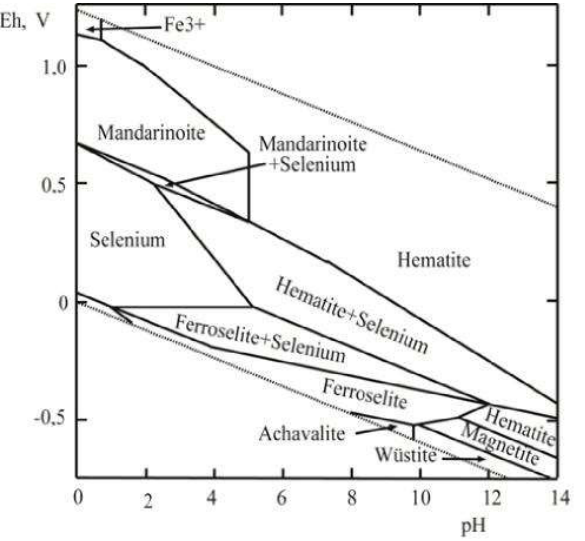
Figure 5. Eh‒pH diagram of Fe-Se-H 2 O system at 25 °C and the activities of the components: a ΣSe = 10 - Figure 5. Eh-pH diagram of Fe-Se-H 2 O system at 25 ◦ C and the activities of the components: a Σ Se = 5 , a ΣFe = 10 -2 . 10 − 5 , a Σ Fe = 10 − 2